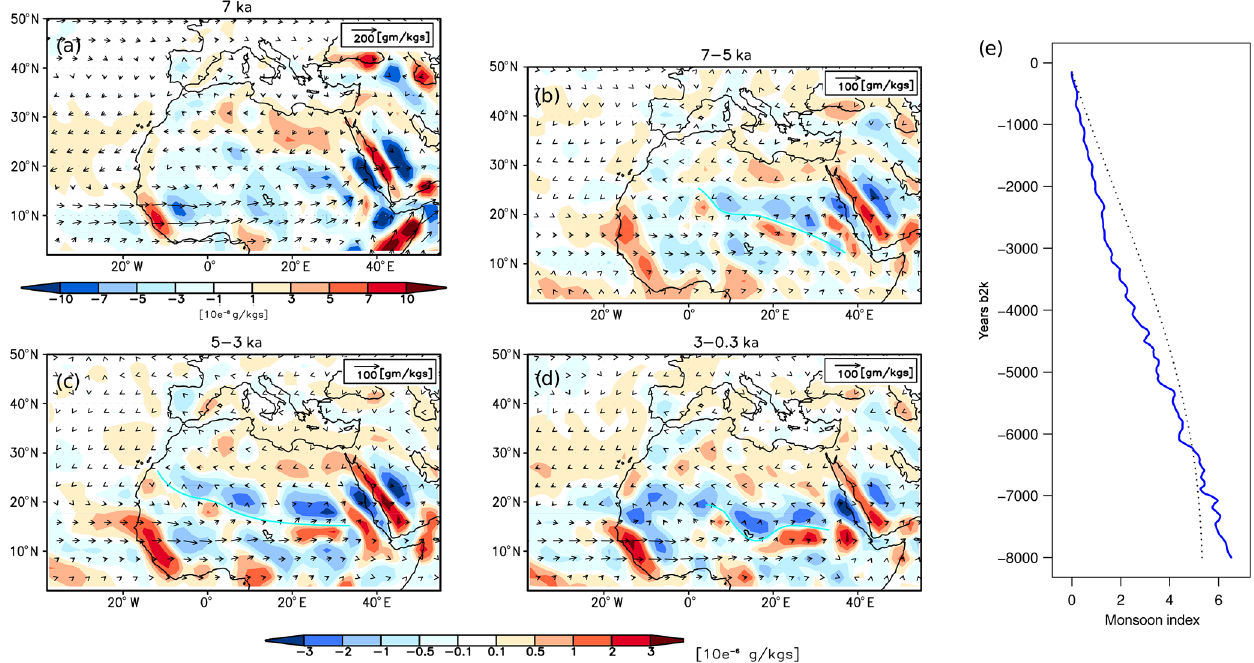
Figure 8. (a–d) Moisture flux (vector, in gkg − 1 ms − 1 ) on the 850hPa level and its divergence (shaded, blue is convergence, red is diver- gence, in 10 × 10 − 5 gkg − 1 s) for the months July–September (adjusted to fixed-angular calendar definition) for (a) 7ka and the differences (b) 7–5ka, (c) 5–3ka, and (d) 3–0.3ka. In (b, c, d) , the cyan line marks the area of transition between divergence and convergence related to the southward retreat of the monsoon rainband. (e) Smoothed change in monsoon strength, based on a simple index ( q · u , averaged over the region 10 ◦ W–0 ◦ E, 8–18 ◦ N, blue), and the Rossignol-Strick Index (Rossignol-Strick, 1985) (black), both as relative change compared to PI ( t − PI / PI).